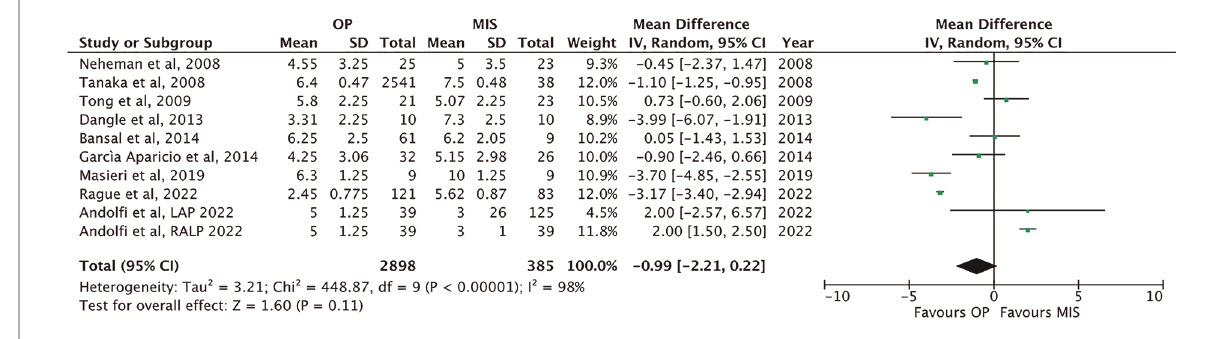
FIGURE 2 Forest plot comparison of age at procedure between OP and MIS in